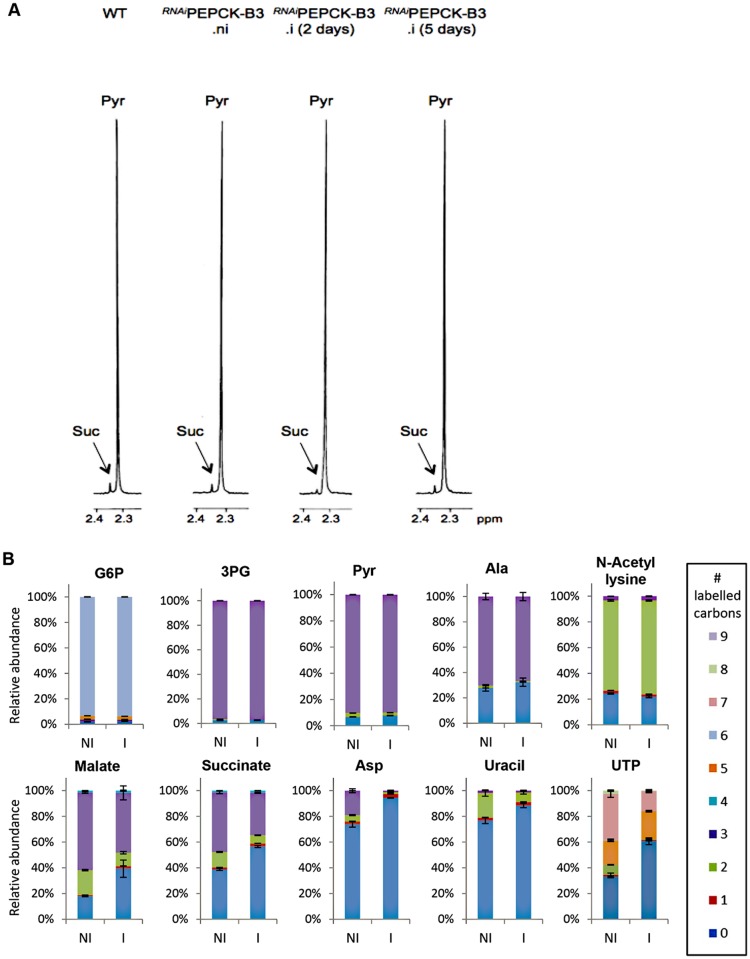
Metabolic profile of RNAiPEPCK-B3 BSF T. brucei confirms depletion of dicarboxylic acids and pyrimidines.(A) Proton (1H) NMR analysis of excreted pyruvate and succinate from glucose. Pyruvate (Pyr) and succinate (Suc) excreted by the bloodstream form 427 cell line (WT), and the RNAiPEPCK-B3 mutant non-induced (ni), tetracycline-induced 2 days (i 2 days), and tetracycline-induced 5 days (i 5 days) was determined by 1H-NMR. The cells were incubated in PBS containing 4 mM glucose for 4 hours. Each spectrum corresponds to one representative experiment from a set of at least 3. A part of each spectrum ranging from 2.2 ppm to 2.4 ppm is shown. (B) LC-MS analysis of intracellular glycolytic intermediates. Relative isotopologue abundances following incubation in PBS containing 4 mM U-13C-glucose for 4 hours for metabolic intermediates from RNAiPEPCK-B3 mutant non-induced (NI) and tetracycline-induced for 2 days (I). Significant decreases in labelling were observed for PEPCK-derived metabolites including 3-carbon labelling in dicarboxylic acids and aspartate, and 2-carbon labelling in pyrimidine nucleotides (or 7-carbon labelling for ribose-containing metabolites). Labelling was not significantly decreased in glycolytic intermediates or in other glucose-derived metabolites, including alanine, acetate (shown here as acetyllysine) and ribose (shown here as 5-carbon labelling in UTP).